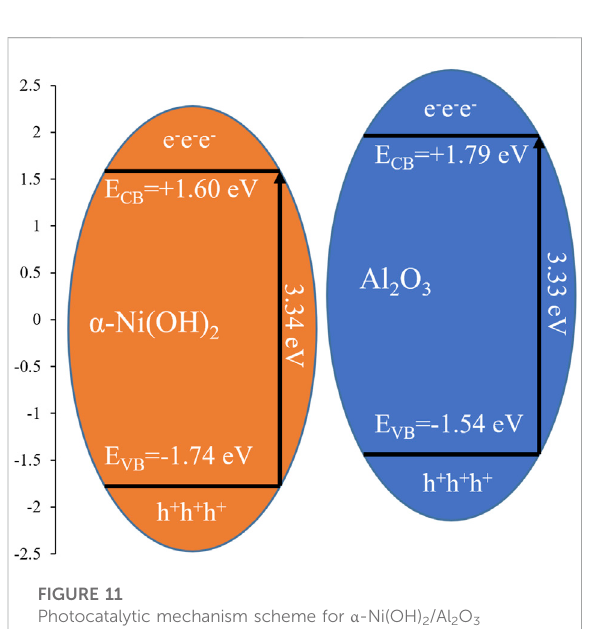
FIGURE 11 Photocatalytic mechanism scheme for α -Ni(OH) 2 /Al 2 O 3 under visible light